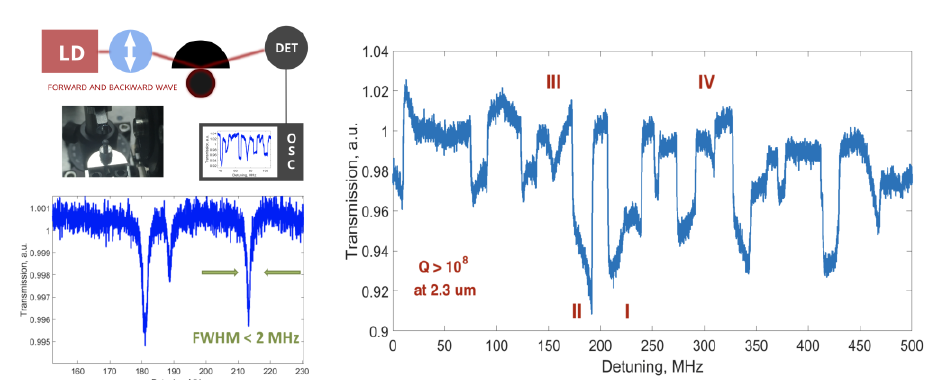
Fig. 1. Top left is a sketch of an experimental setup. Bottom left is the spectrum of WGM modes in the undercoupled regime. The quality factor of the resonator is determined at half maximum of the line. On the right is a mode spectrum of a laser diode in the self-injection locking